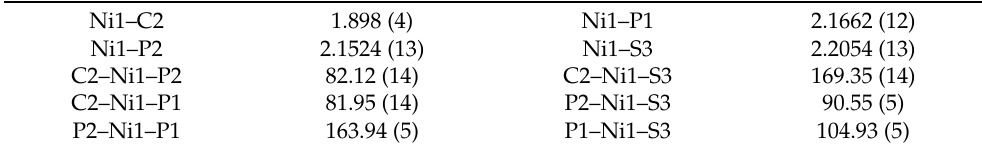
Table 2. Selected geometric parameters (Å, ◦ ) for ( 2 ).